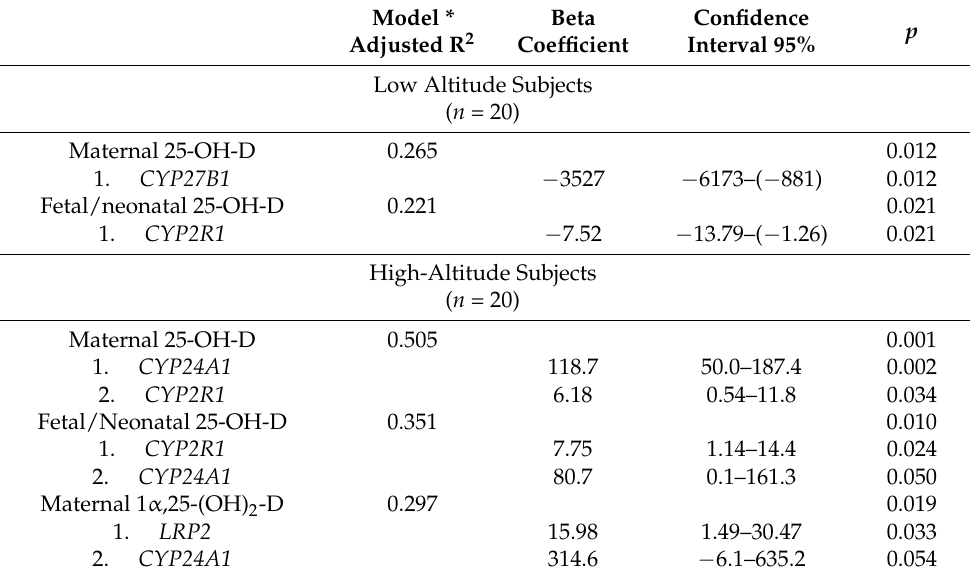
Table 3. Placental determinants of vitamin D levels in Bolivian